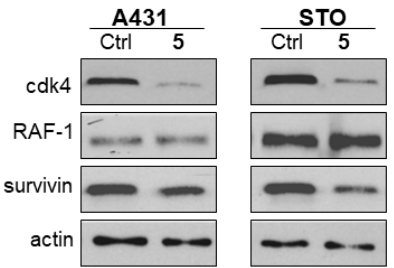
Figure 4. Analysis of HSP90 client protein levels in squamous-cell carcinoma (A431) and peritoneal mesothelioma (STO) cells after 24 h of treatment with compound 5 (5.4 µ M in A431 cells; 2.7 µ M in STO cells). Total cellular extracts were obtained 24 h after cell treatment. Actin is shown as a control for protein